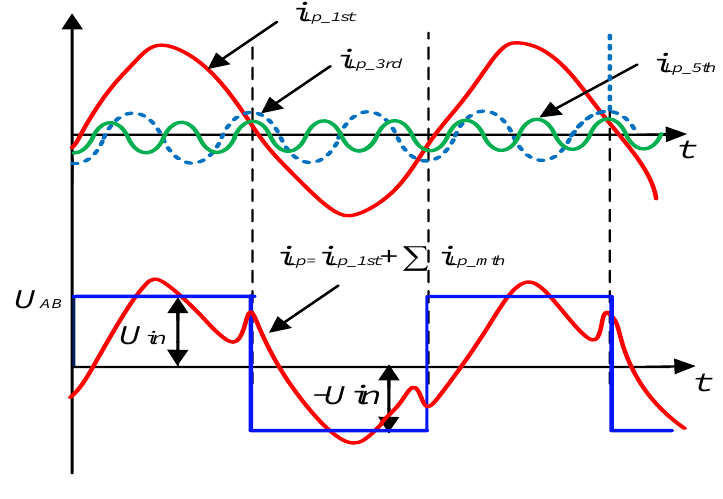
Figure 4. Effect of high order inverter current.